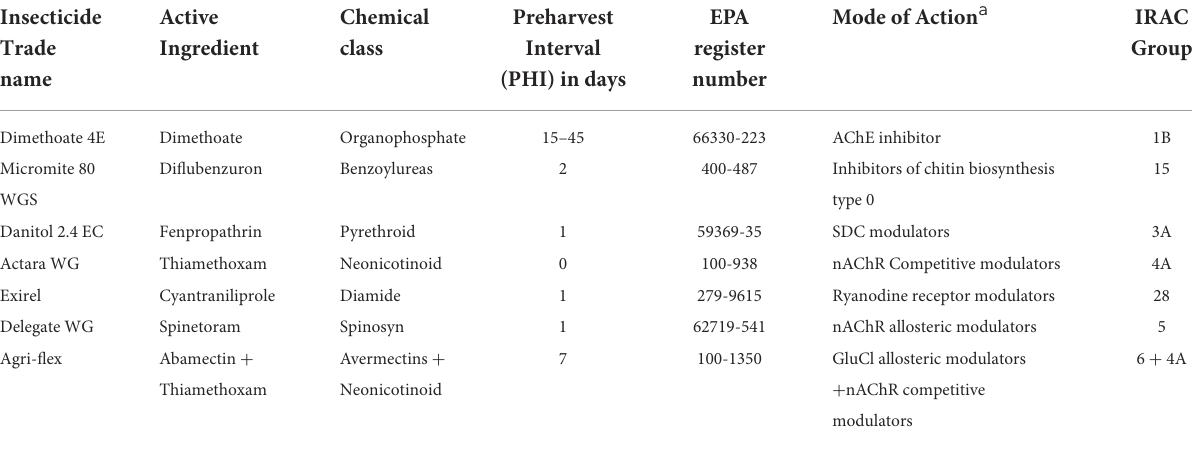
TABLE 1 Insecticides evaluated with various economic threshold treatments for suppression of Diaphorina citri . Insecticide